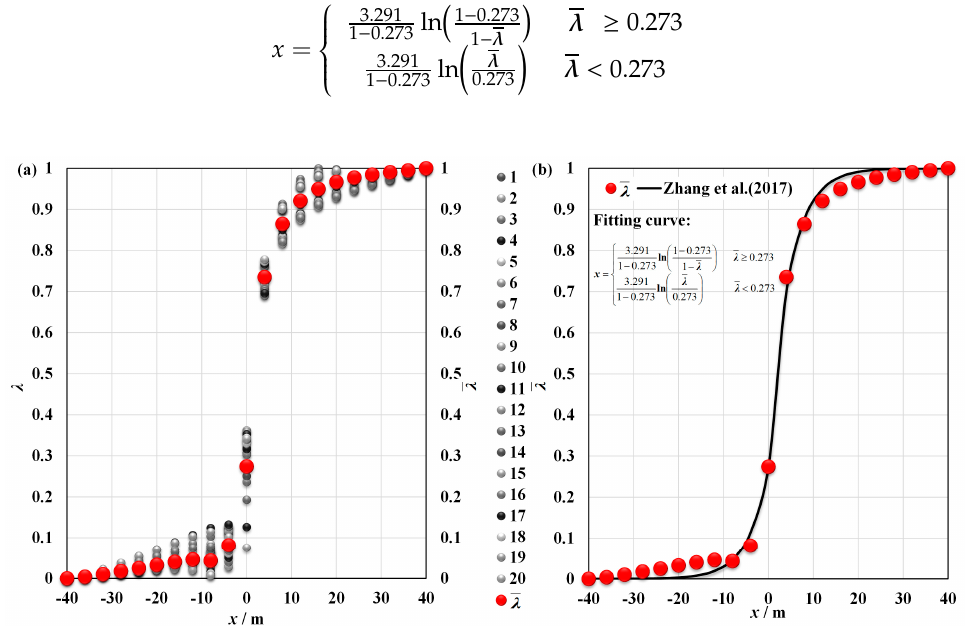
Figure 10. Longitudinal displacement profile: ( a ) x − λ and x − λ , ( b ) the fitting result of x − λ .